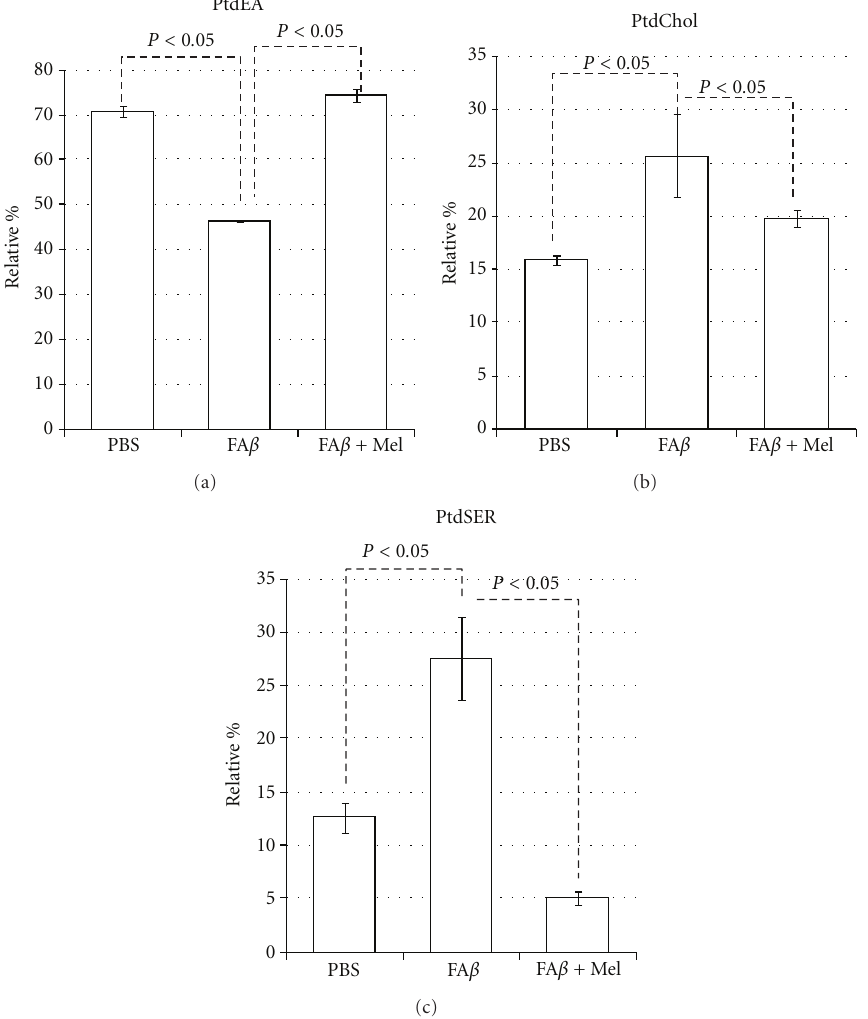
Figure 8: A β decreased significantly the PtdEA levels and increased the levels of PtdCHOL and PtdSER, the latter with a 5-fold increment. Results are expressed in relative percentage ± standard